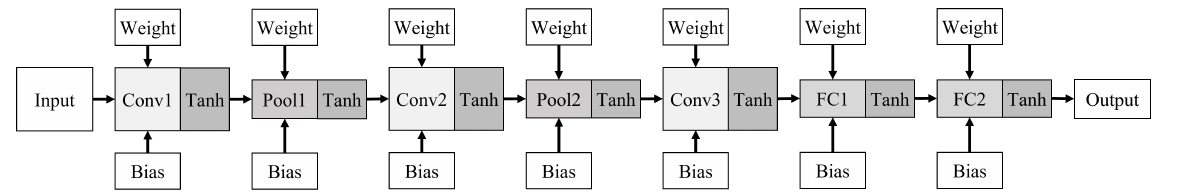
Figure 4. Structural data flow of the LeNet-5 CNN architecture [31]. Table 1. Layer configuration of LeNet-5